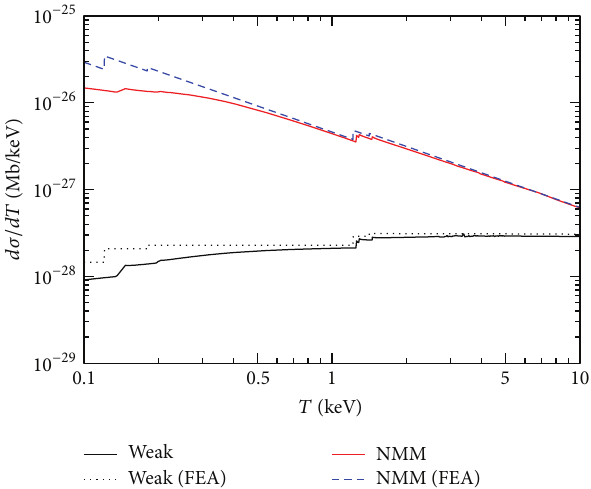
Figure6:TheSM(weak)andNMMcontributionstothedifferential cross section of ] 𝑒 -Ge ionization at 𝐸 ] = 1 MeV [60] in comparison with the corresponding stepping-approximation results (FEA). The NMM value is set to be the current upper limit 𝜇 ] = 2.9 × 10 −11 𝜇 𝐵